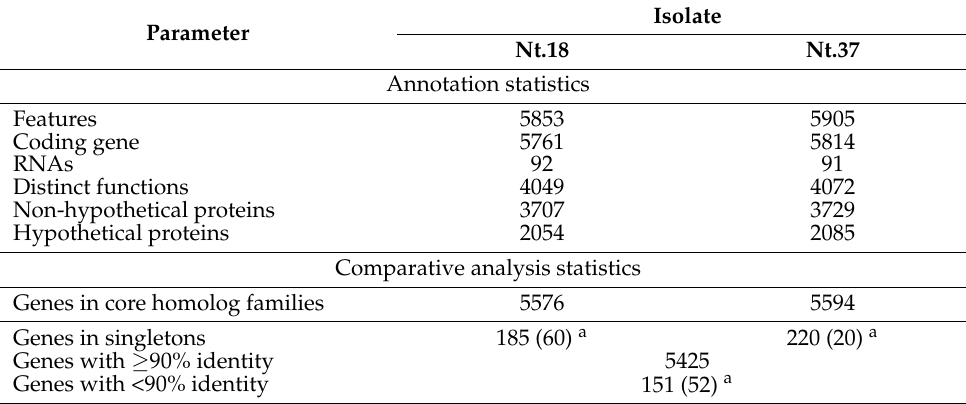
Table A4. Statistics of genome annotation and comparative analysis of closely related B. toyonensis isolates Nt.18 and